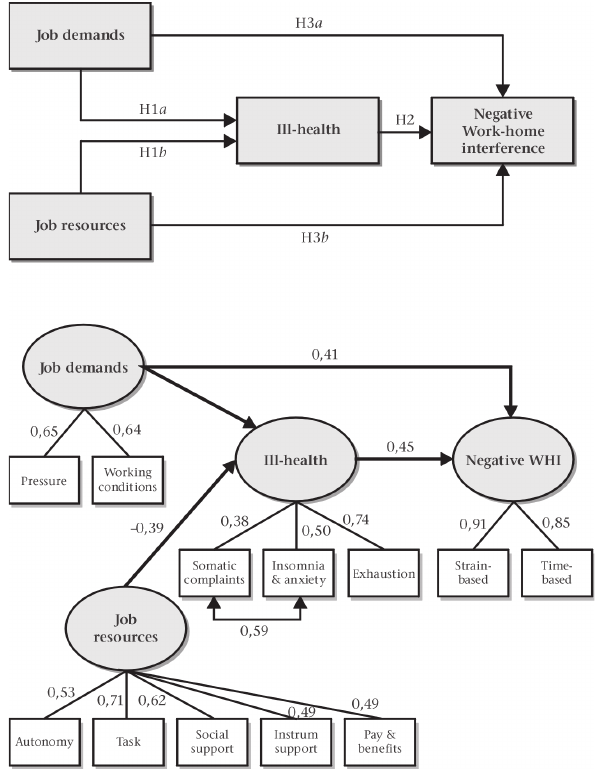
figure 2: Standardised parameter estimates for the final model. All factor loadings and path coefficients are statistically significant, p <